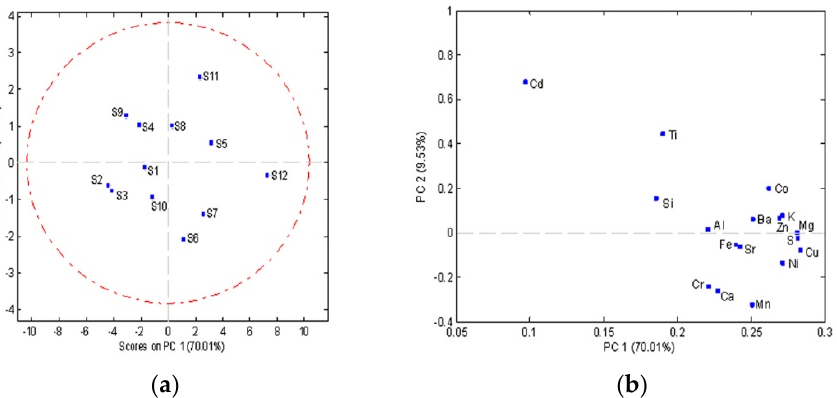
Figure 3. Analysis of the main components based on the content of 17 elements in chocolate samples; ( a ) Score plots of the first two principal components; ( b ) loading plots.